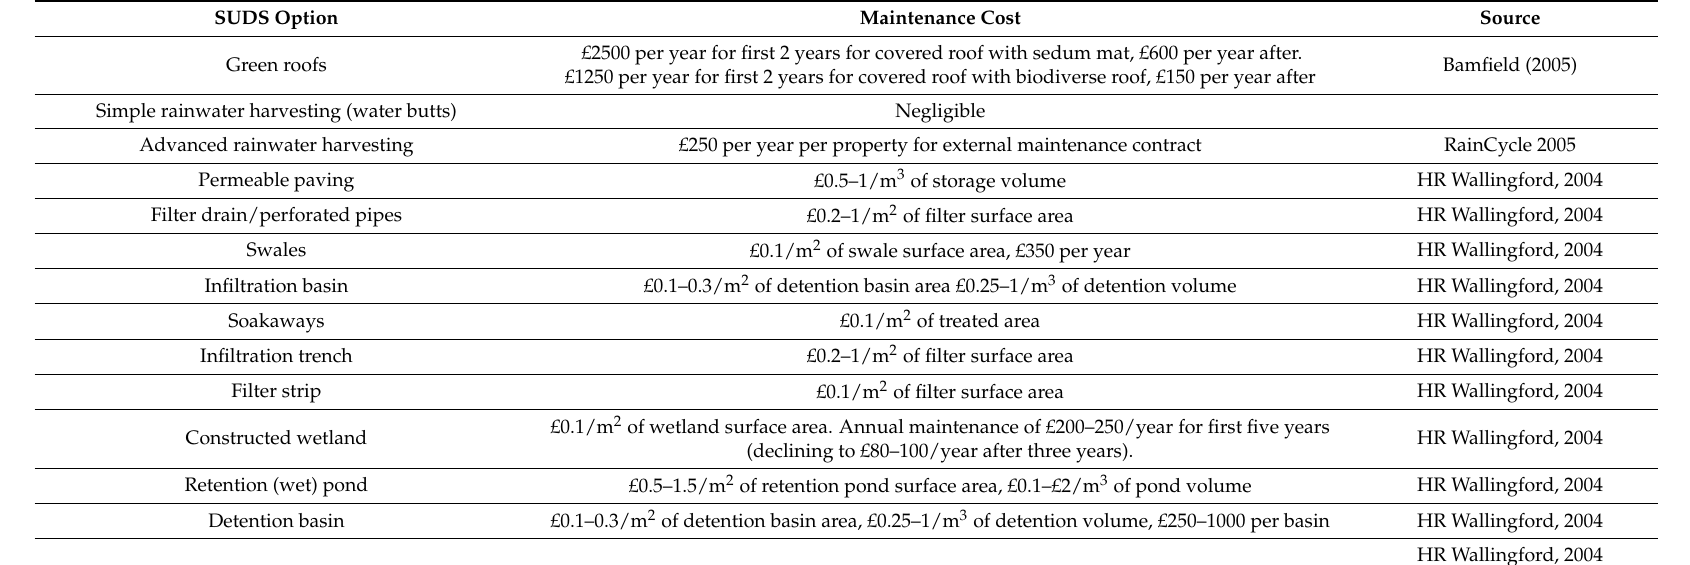
Table A6. Operation and maintenance costs for sustainable urban drainage solutions (SUDS) (Env, Agency [94]).